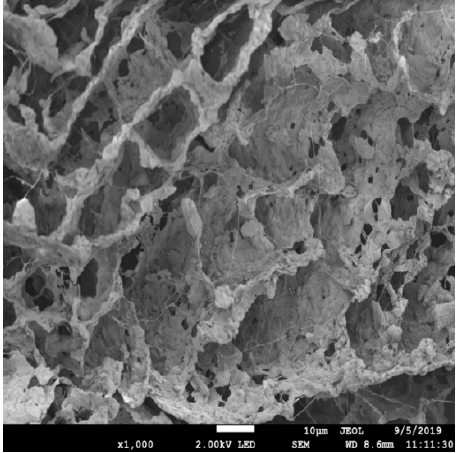
Figure 4. Composite gel (BHCT-2) microstructure.